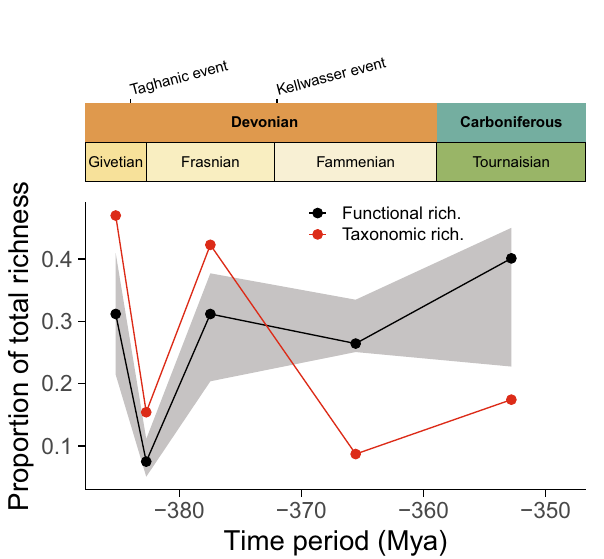
Figure 3. Functional and taxonomic richness of tabulate coral assemblages from the Givetian to the Carboniferous. Grey ribbon indicates 95% confidence intervals of the trait sensitivity